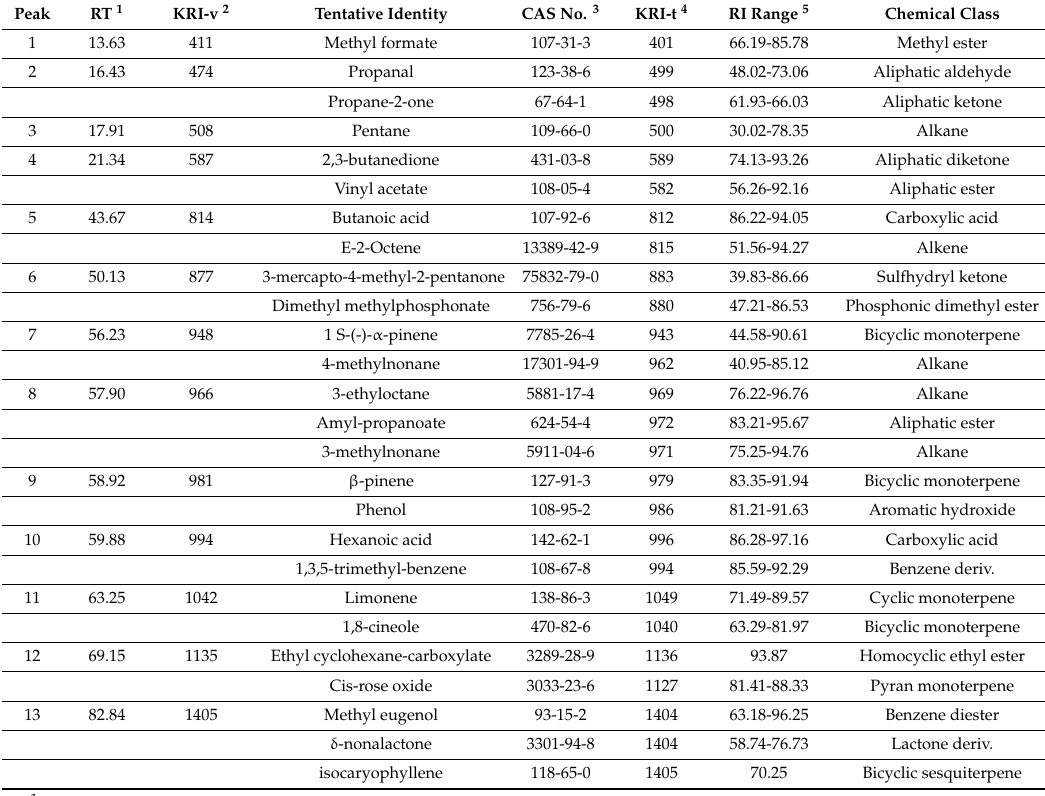
Table 5. Gas chromatographic data indicating tentative identities of constitutive VOC-metabolite emissions derived from host sapwood of green